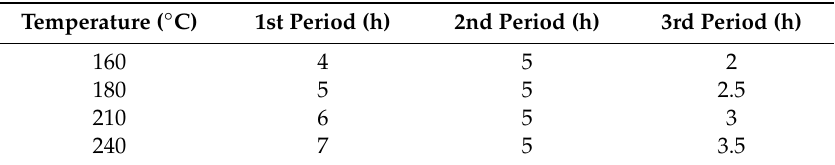
Table 1. Schedule of the thermal